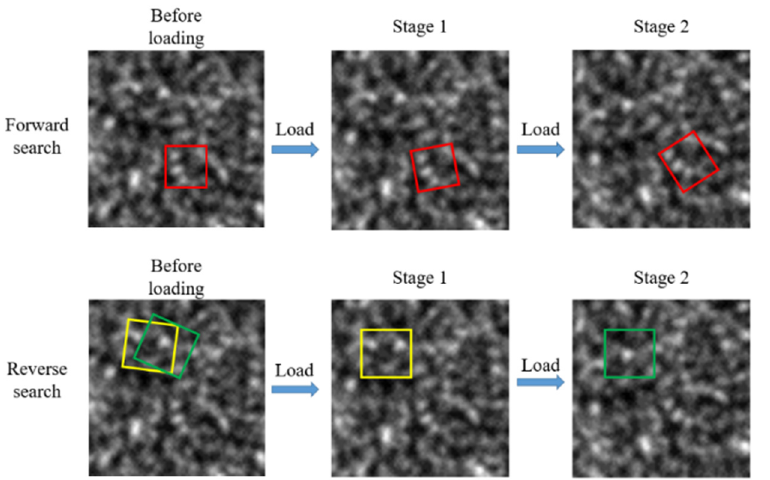
Figure 4. Comparison between forward search and reverse search strategy. In top figures, the reference sub-region (the red box) is searched in different deformed images. The bottom figures show that the reverse search method search the deformed sub-regions (the yellow and green box) in the reference image, which is constant and precalculated. For clarity, only two deformed images are displayed.